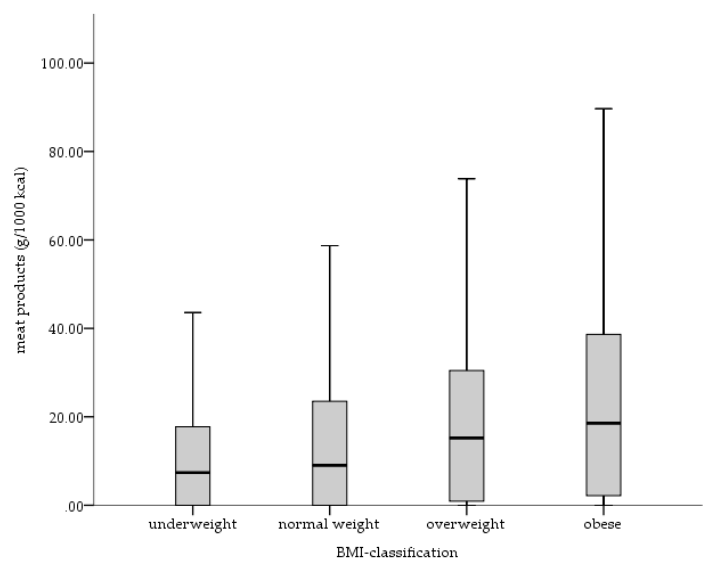
Figure 3. Daily intake of meat products (g/1000 kcal) by BMI-groups.